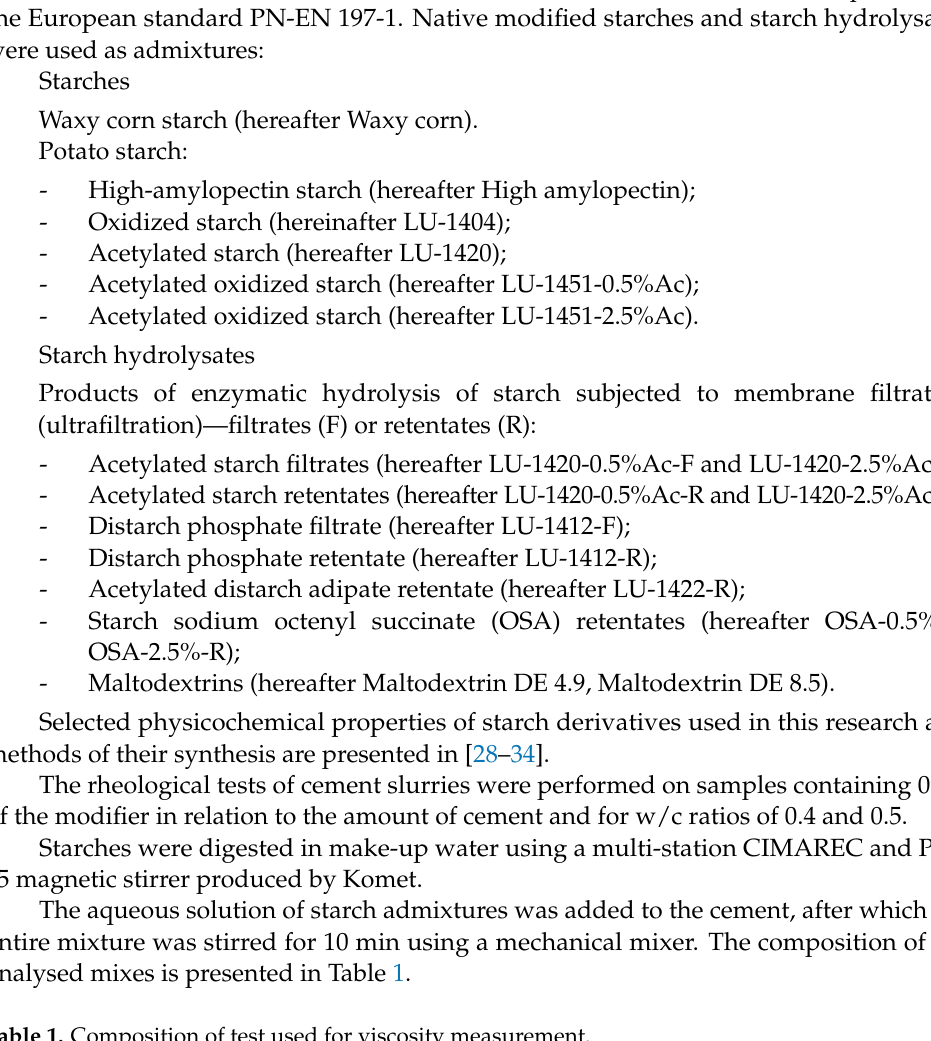
Table 1. Composition of test used for viscosity